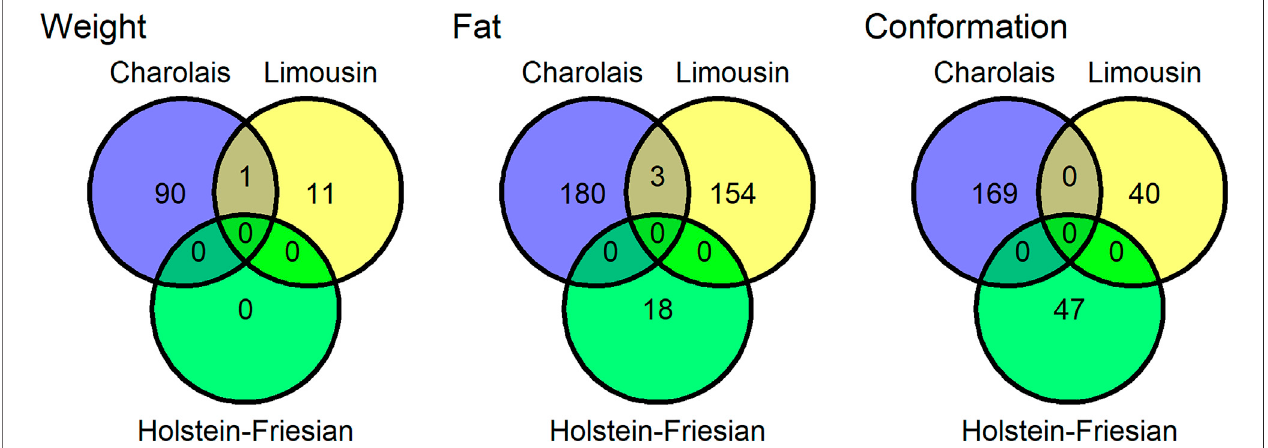
FIGURE 2 | The number quantitative trait loci (QTLs) associated with carcass weight, carcass fat, and carcass conformation for the Charolais, Holstein-Friesian, andLimousinpopulations.QuantitativetraitlocithatoverlappedingenomicpositionwithanotherQTLassociatedwiththesametraitinanotherbreedwereconsidereda single QTL shared between the two